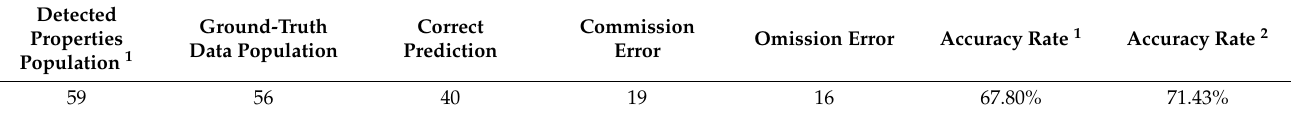
Table 6. Commission and Omission Errors.